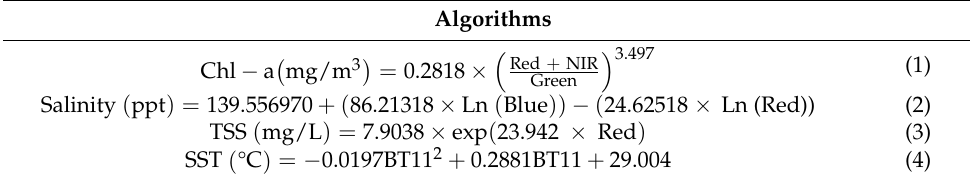
Table 1. Selected algorithms for predicting lobster catches.